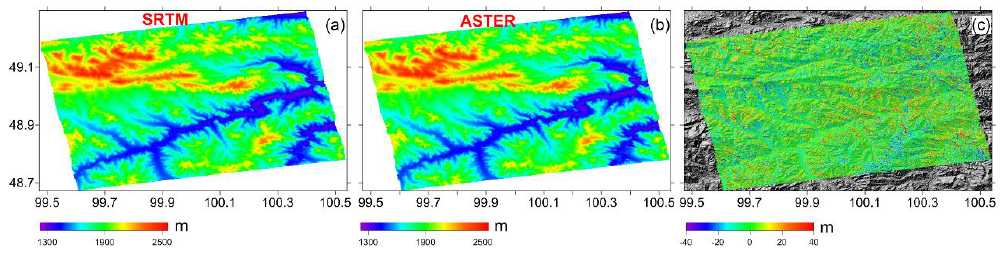
Figure 11. ( a ) SRTM DEM. ( b ) ASTER DEM. ( c ) Difference map between the SRTM DEM and the ASTER DEM.